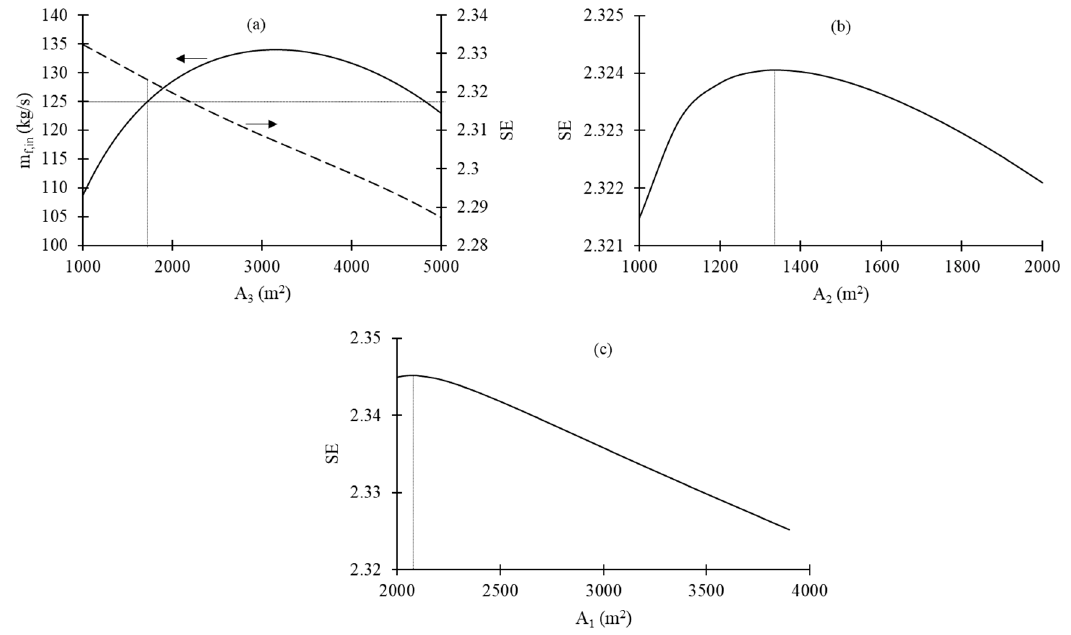
Figure 5. Procedure for determining the optimum distribution of evaporator area in the modified evaporation process driven by extracted steam at a pressure ( p 0 ) of 200 kPa: ( a ) finding A 3 corresponding to the inlet juice mass flow rate ( m f , in ) of 125 kg / s and the maximum steam economy ( SE ) corresponding to A 1 = 4000 m 2 , and A 2 = 1100 m 2 ; ( b ) finding A 2 that maximizes SE corresponding to A 1 = 4000 m 2 ; and ( c ) finding A 1 that maximizes SE .